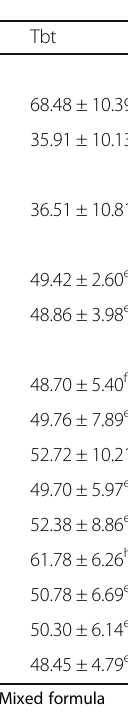
Table 4 Histopathology and histomorphometry of the femur in sham-operated and OVX mice: Trabecular Bones Items